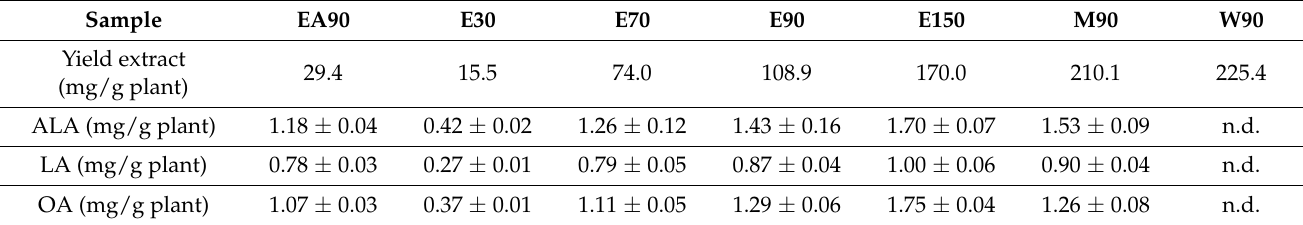
Table 2. Summary of extract yield (mg/g plant) and fatty acid content (mg/g plant) of Waltheria indica leaf extracts obtained with varying extraction temperatures and solvents. EA90, 90 ◦ C ethyl acetate; E30–E70–E90–E150, 30–70–90–150 ◦ C ethanol; M90, 90 ◦ C methanol; W90, 90 ◦ C water; n.d., not detectable. Values are means ± standard deviations of triplicate